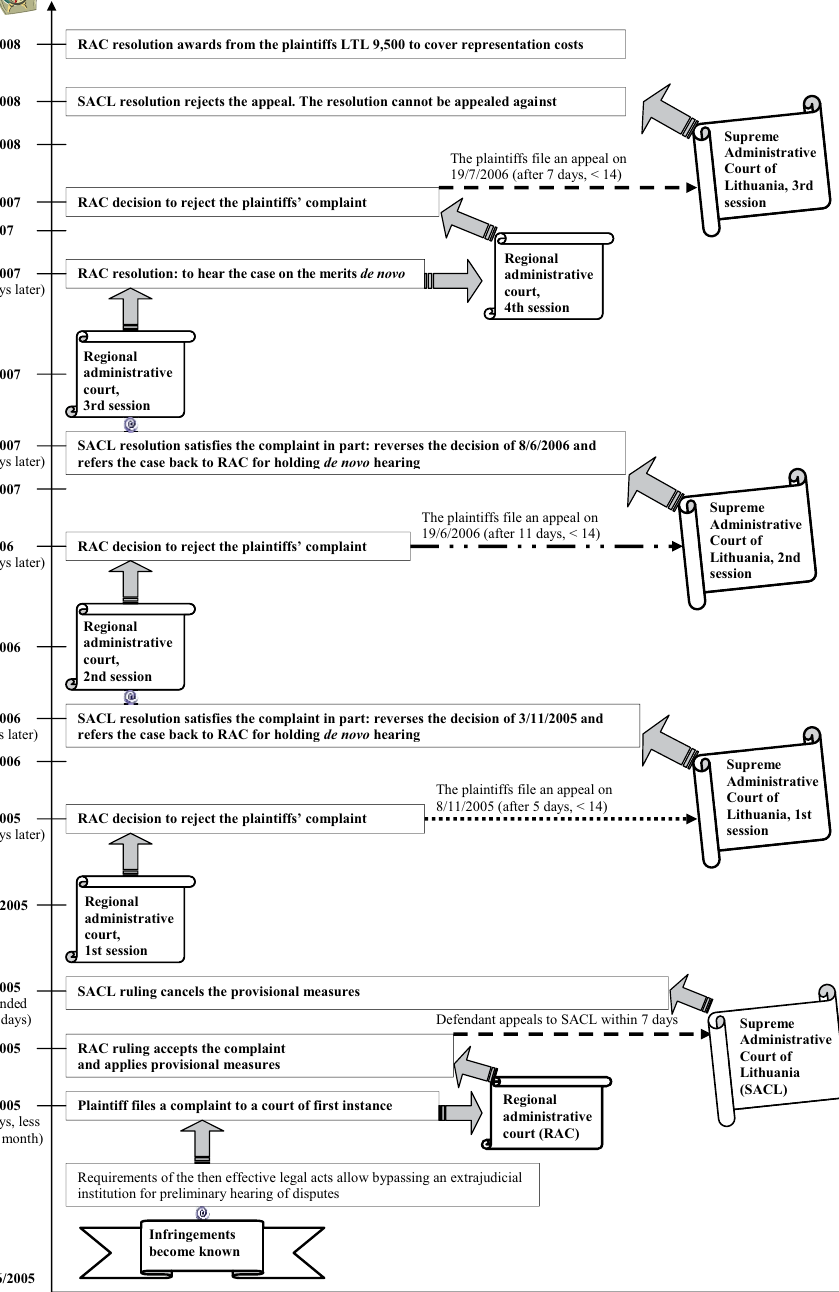
Fig. 1. Defence of infringed rights in an administrative court, an actual case (diagram compiled by the